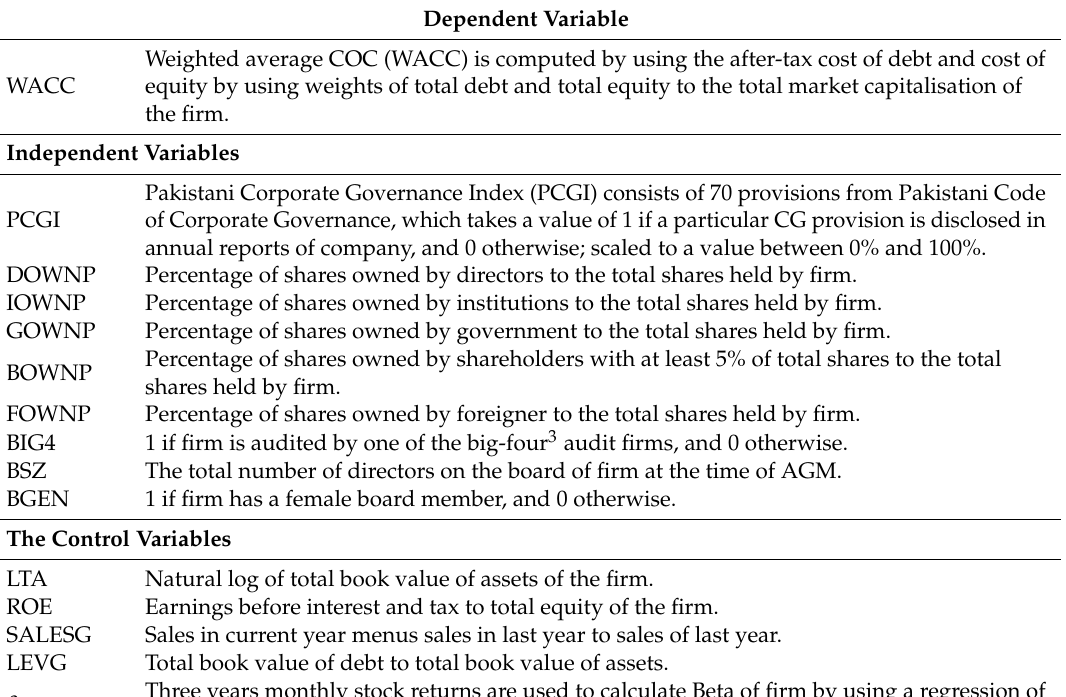
Table A1. Summary of variables used in CG mechanisms and firm COC